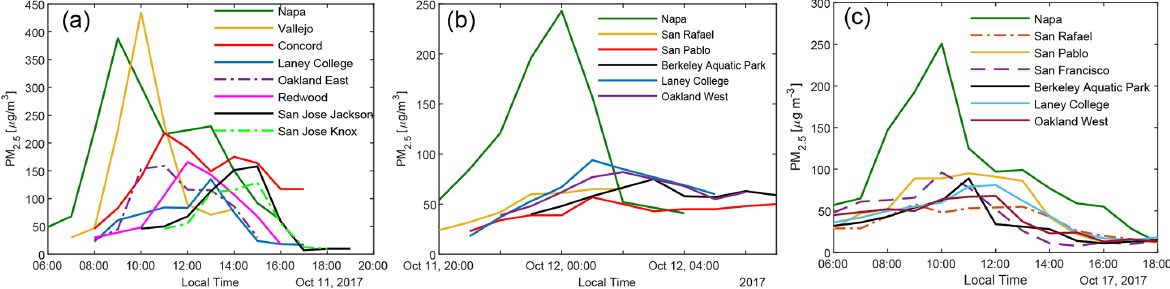
Figure 2. Hourly PM 2 . 5 concentration measured at BAAQMD sites affected by the fires plumes on (a) 11 October 2017, (b) the night of 11 October to the early morning of 12 October 2017, and (c) 17 October 2017.